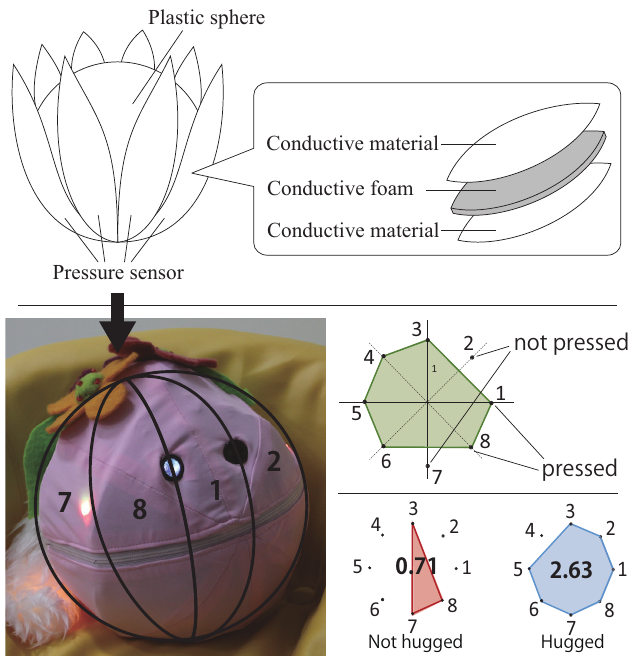
Figure 4. ( Top ) Pressure sensor’s arrangement: each petal-shaped sensor was made of soft conductive foam and attached around the spherical body of the robot. ( Bottom ) Hug detection method: when a piece of the sensor is pressed with certain applied pressure, it generates a point placed in a fixed position on the Cartesian plane. When the area of the polygon formed by the generated points exceeds a threshold, the device recognizes the action as a